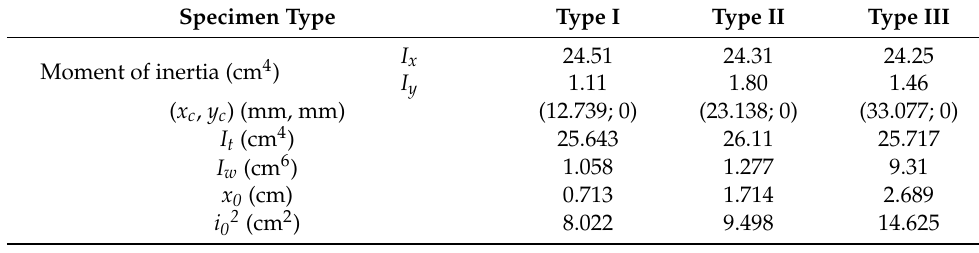
Table 1. The parameter values for Equation